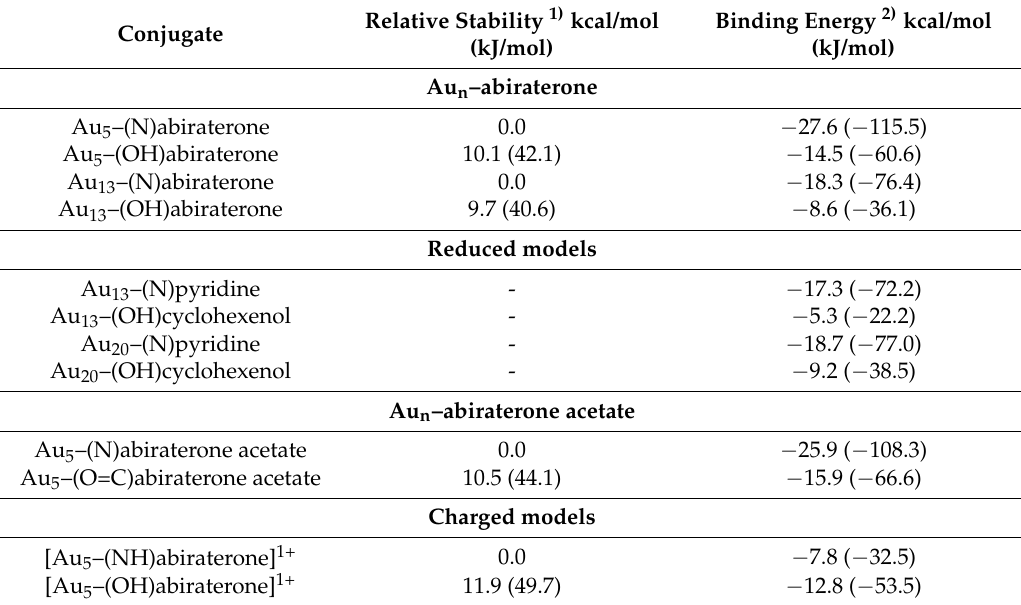
Table 2. Relative stability and binding energy of the Au n –AB conjugates and Au n –AB reduced